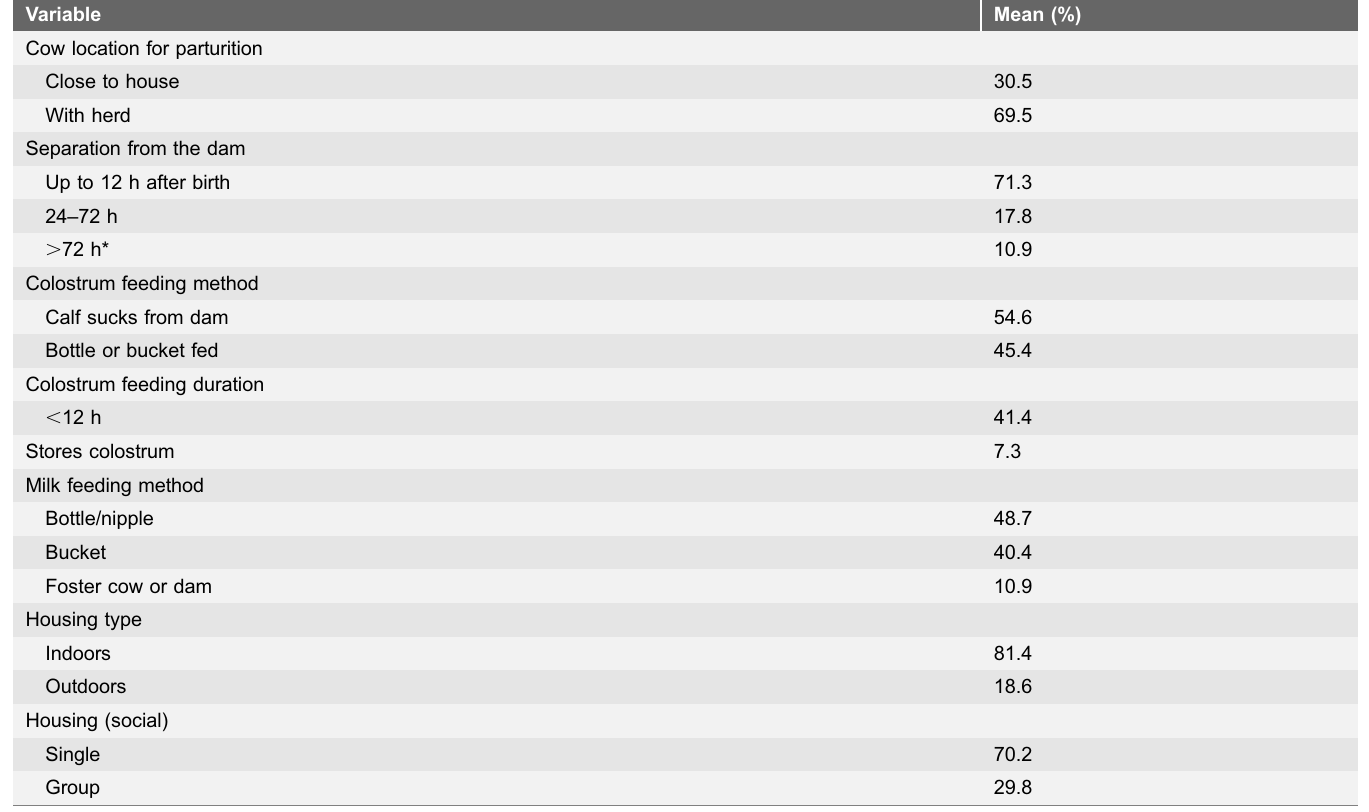
Table 2. Neonatal, feeding and housing practices, as reported by smallholder dairy farmers of Santa Catarina State, Brazil (n 5